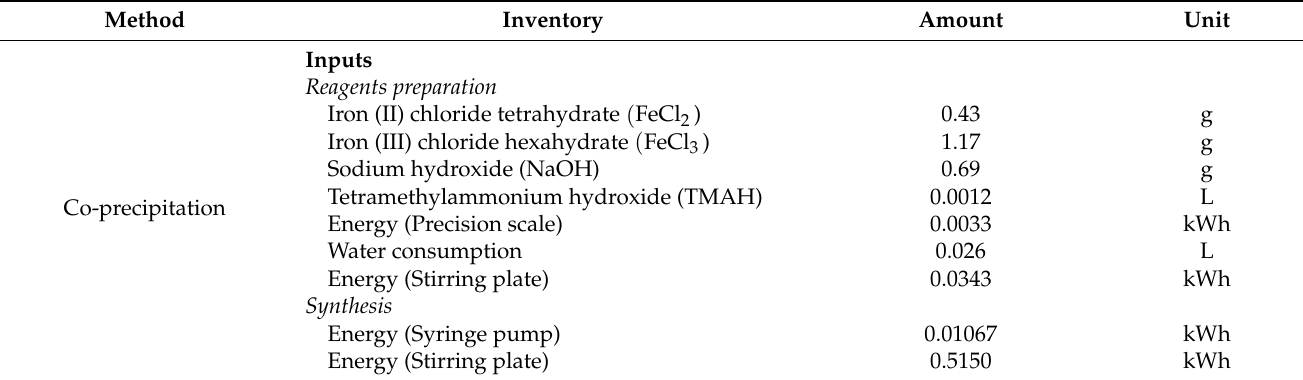
Table 2. Inventory report of co-precipitation and micromixer-based synthesis methods.